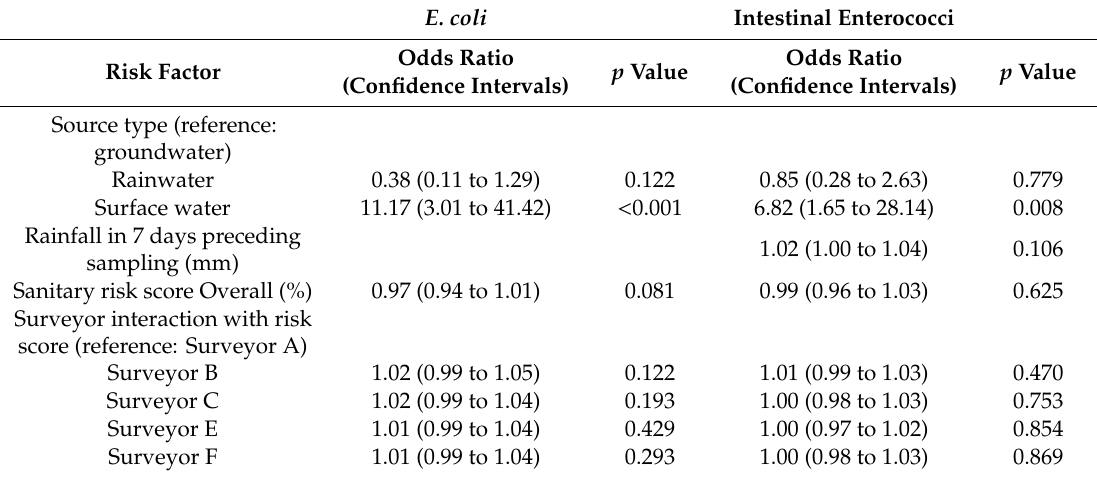
Table 4. Odds ratios for risk factors for high contamination ( > 150 CFU / 100 mL) of source water with E. coli and intestinal enterococci based on multivariate logistic regression of 99 samples from 77 water points visited by all five surveyors (Surveyor D, who did not participate in dry season fieldwork, is